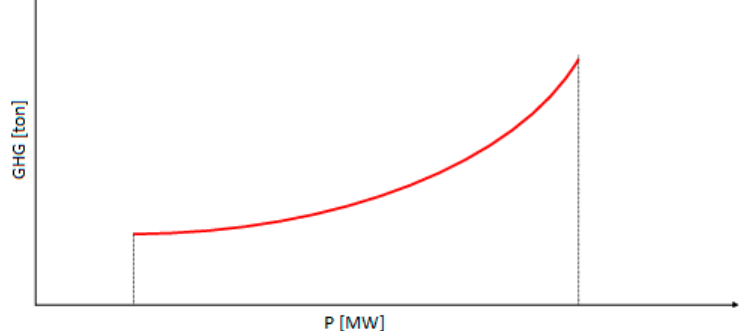
Figure 1. Greenhouse gas (GHG) emissions quadratic function example.